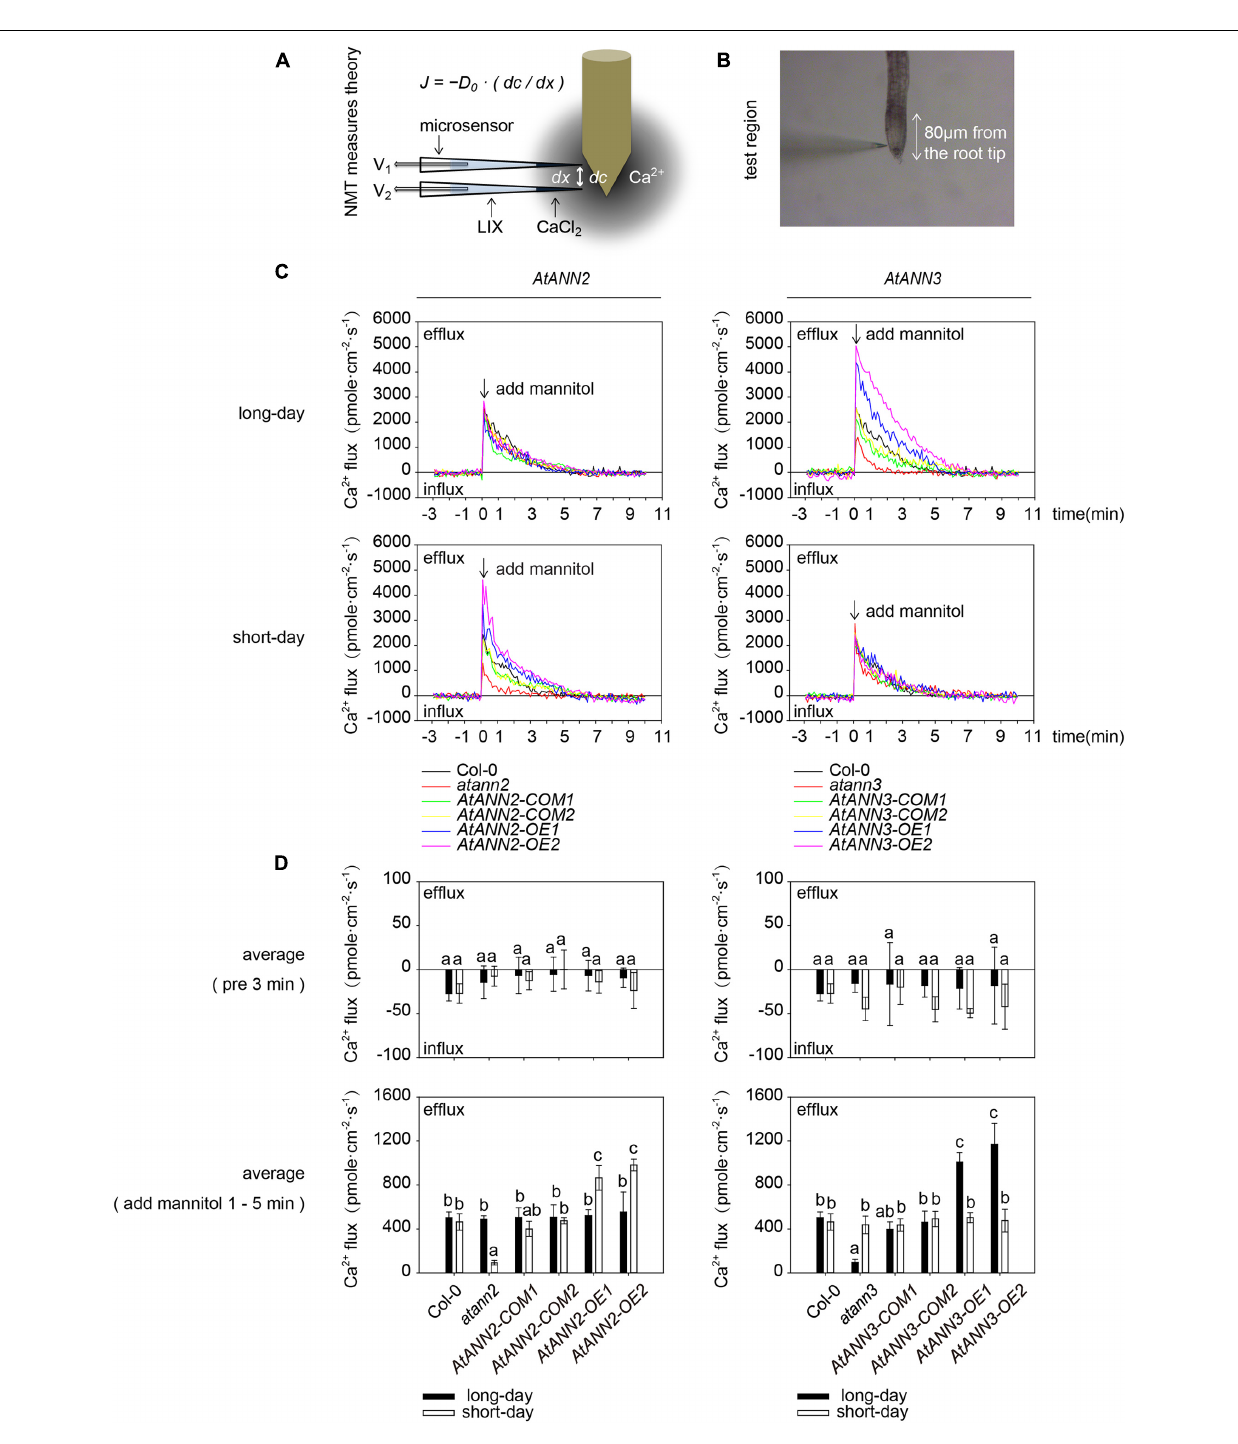
Frontiers in Plant Science |